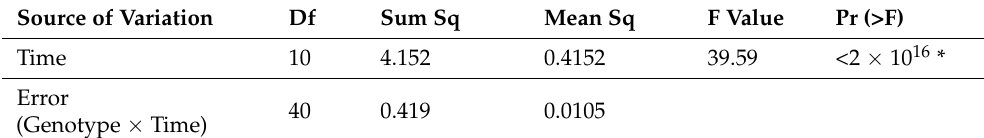
Table 5. Repeated Measure ANOVA for leaf total ODAP content during 2011–2012.